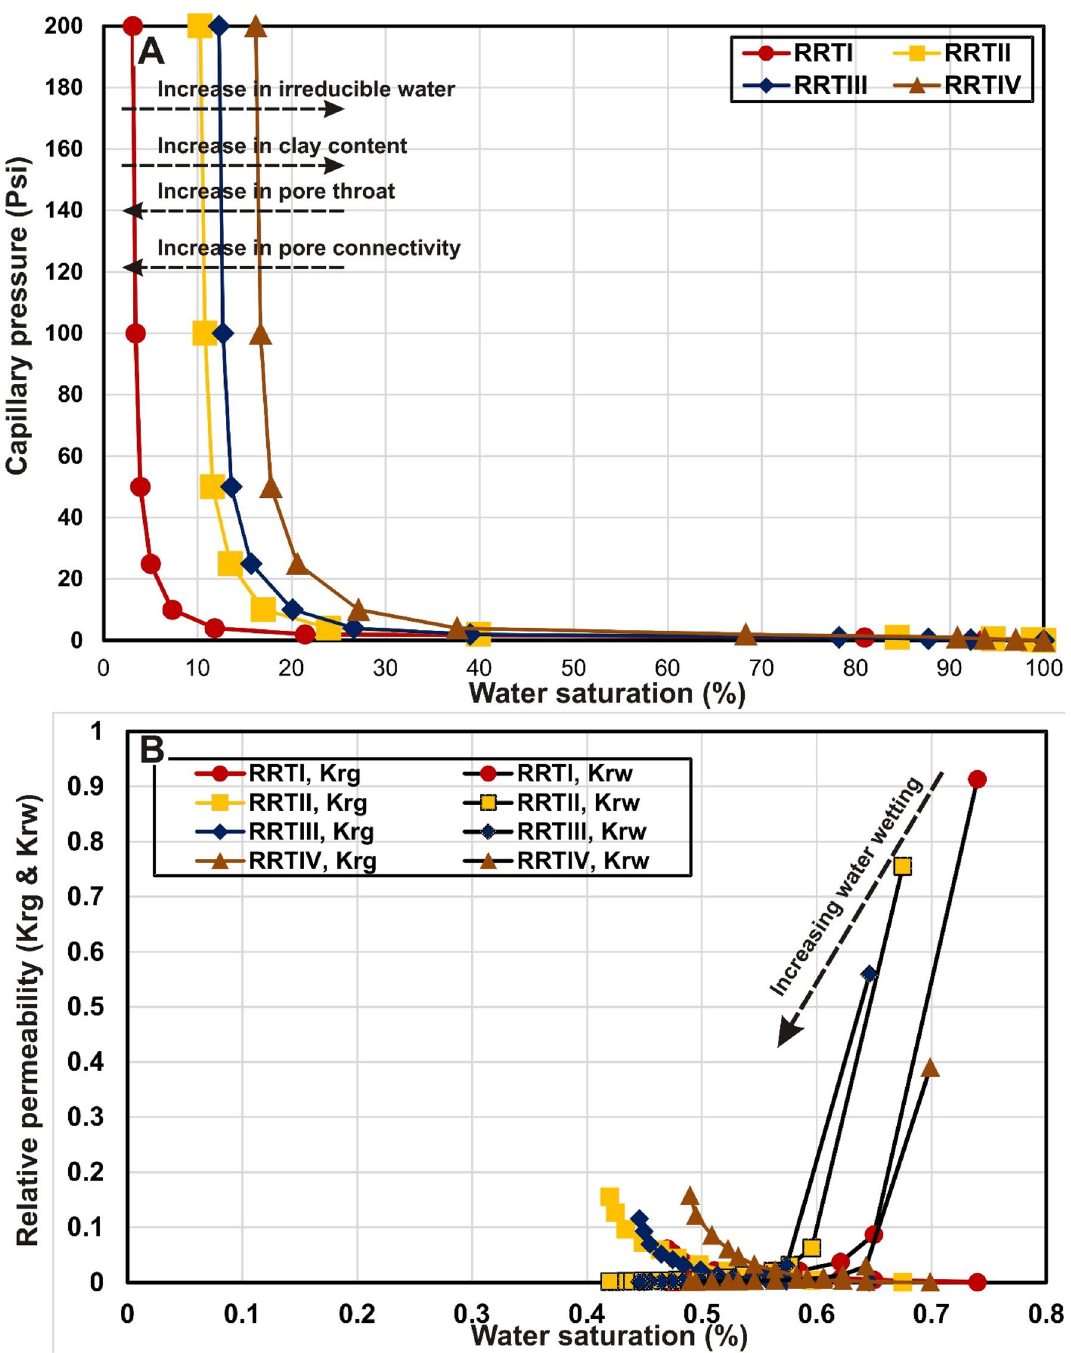
Fig. 15 Water saturation versus capillary pressure ( a ) and gas, water relative permeability ( b ) illustrating the variations in fluid flow characteris- tics and pore system within the different reservoir rock